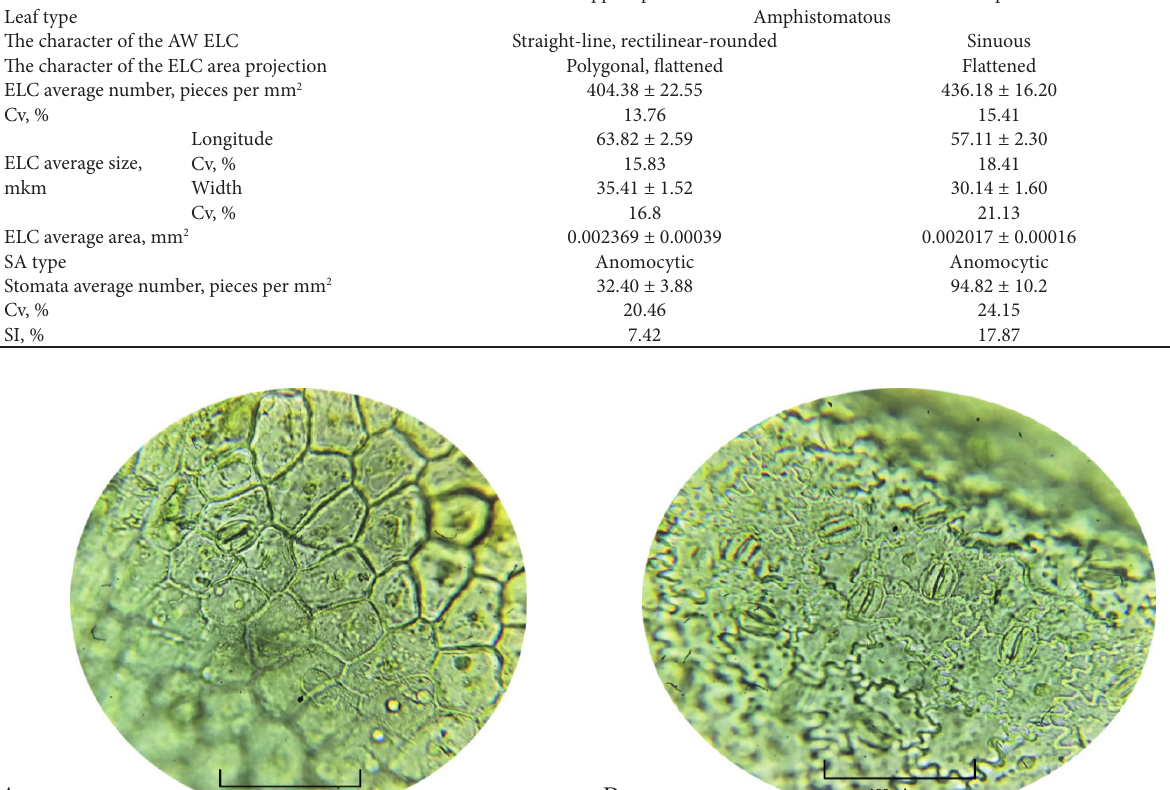
Table 1. Morphometric characteristics of T. pratense leaf epidermal structures. Leaf side